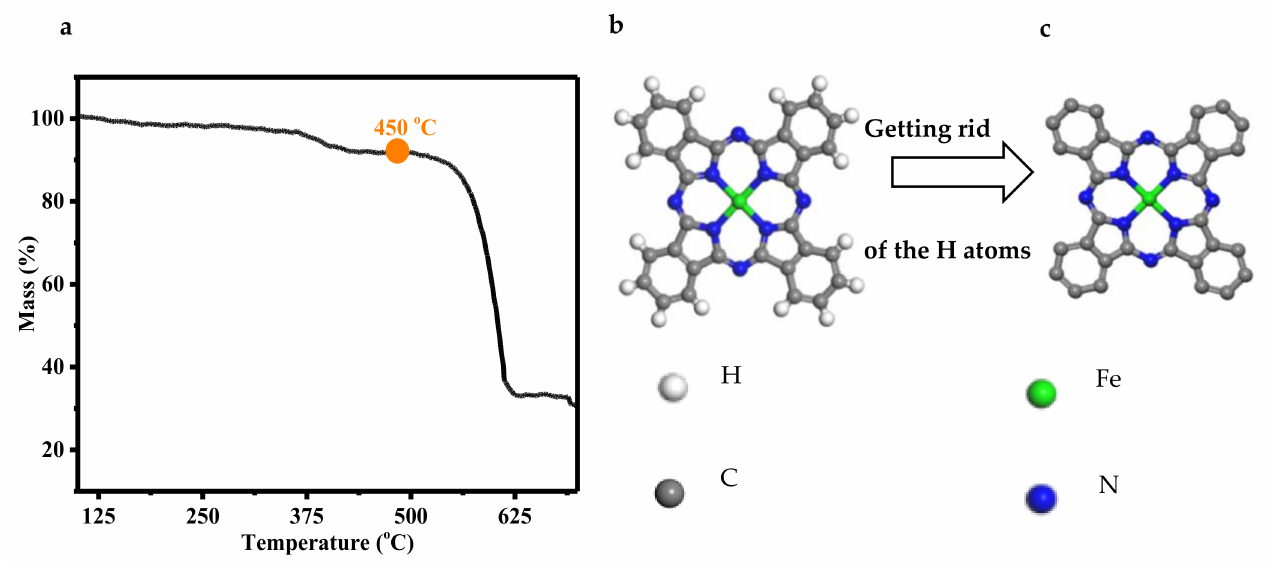
Figure 8. ( a ) Thermogravimetric analysis (TGA) curve of FePc powder; ( b ) ball and stick model of FePc molecule; ( c ) ball and stick model after getting rid of the H atoms in FePc